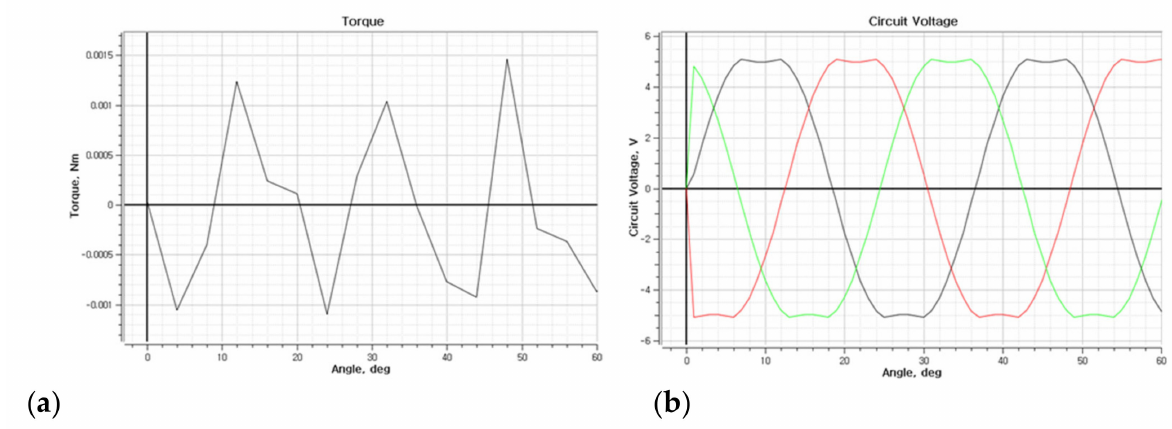
Figure 2. No-load analysis results of the IPM motor. ( a ) Cogging torque at 10 rpm; ( b ) Back-EMV at 1000